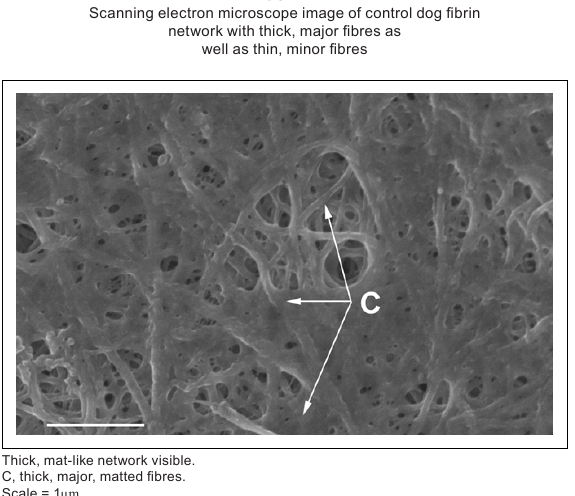
FIGURE 4 Scanning electron microscope image of fibrin network from dog suffering from ischaemic stroke, 24 hours after